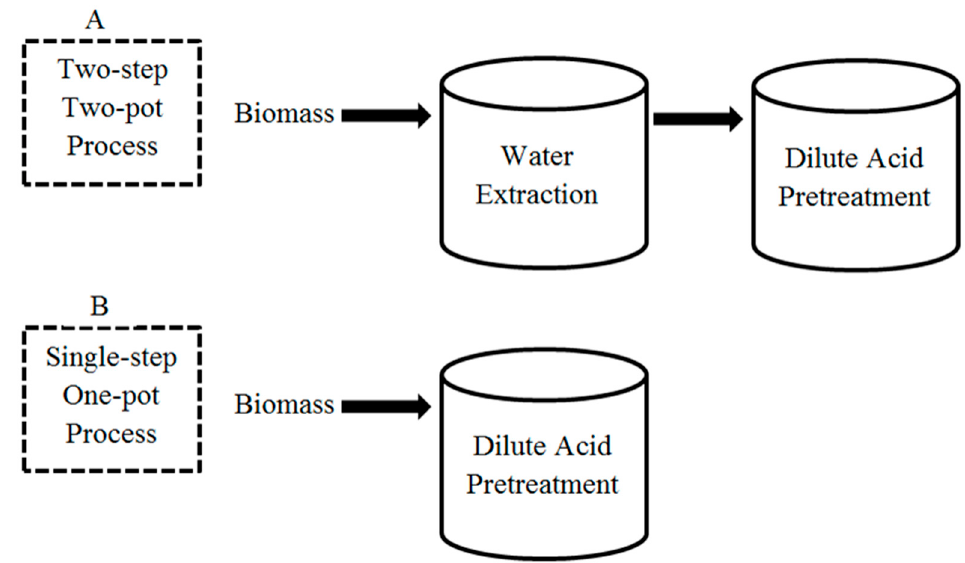
Figure 1. Flowchart of process designs: ( A ) two-step, two-pot process; ( B ): single-step, one-pot process.